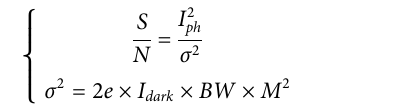
Frontiers in Materials |